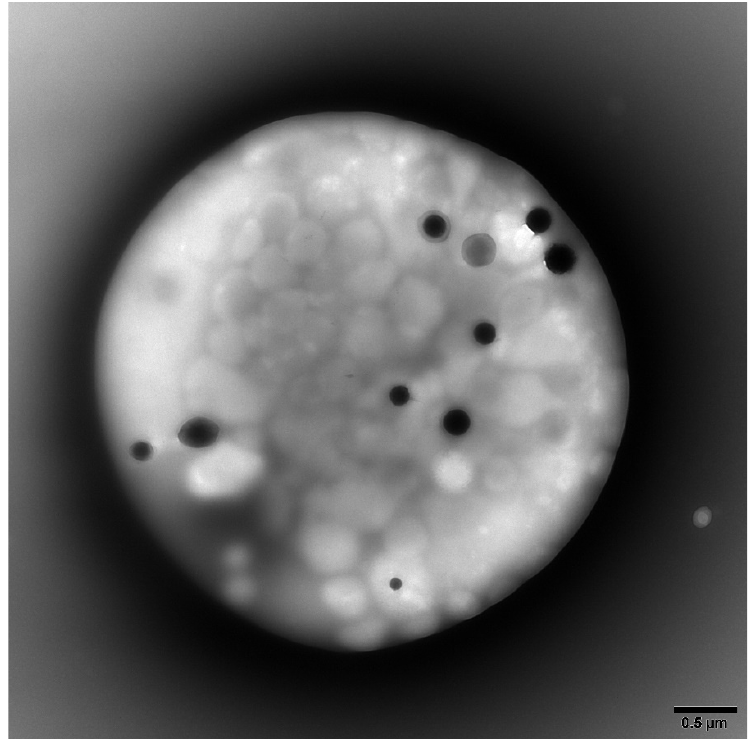
Figure 1. Representative transmission electron microscopy image of a whole mounted and air-dried platelet. Dense granules appear as opaque round bodies (normal = 4–6/platelet; range 0–30/platelet), whereas the ill-defined gray bodies are alpha granules (50–80/platelet).